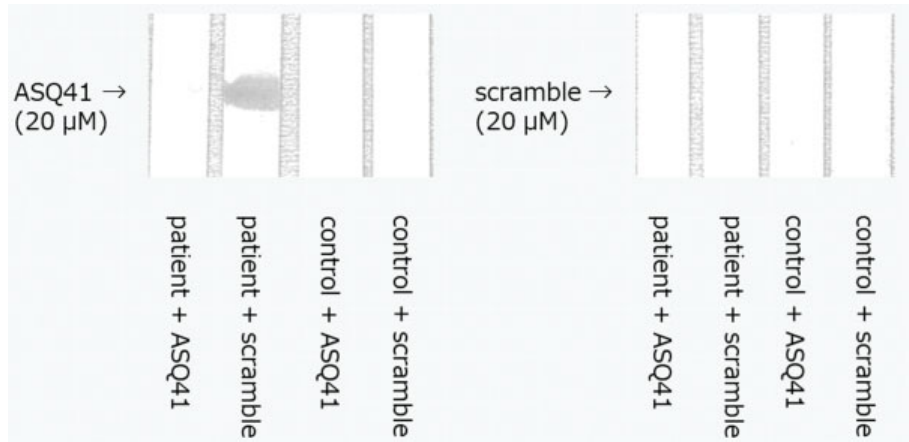
Fig. 4. Inhibition of autoantibodies binding to ASQ41 by peptides. The synthetic peptide ASQ41 or the scramble peptide CRG41 (20 µM) was applied to each lane. After transfer to PVDF membranes, the membranes were incubated with the synthetic peptide ASQ41 or the scramble peptide CRG41 (20 µM solution) and either anti-ASQ41-positive patient plasma samples or normal control plasma. Next, immunoblotting was performed. PVDF, polyvinylidene di fl uoride.